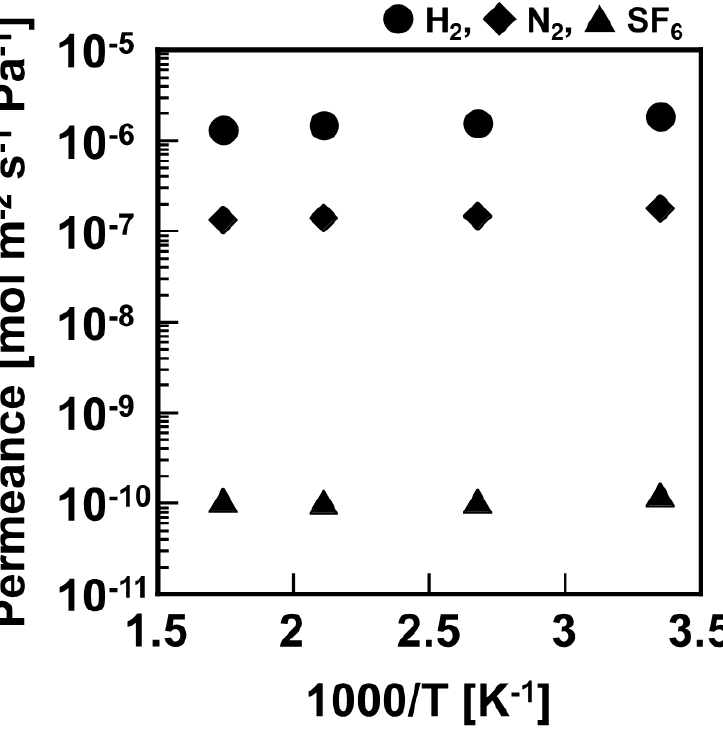
Figure 4. Temperature dependence of permeation performance through 500 mm-length silica membrane derived from DMDPS at 573–298 K.